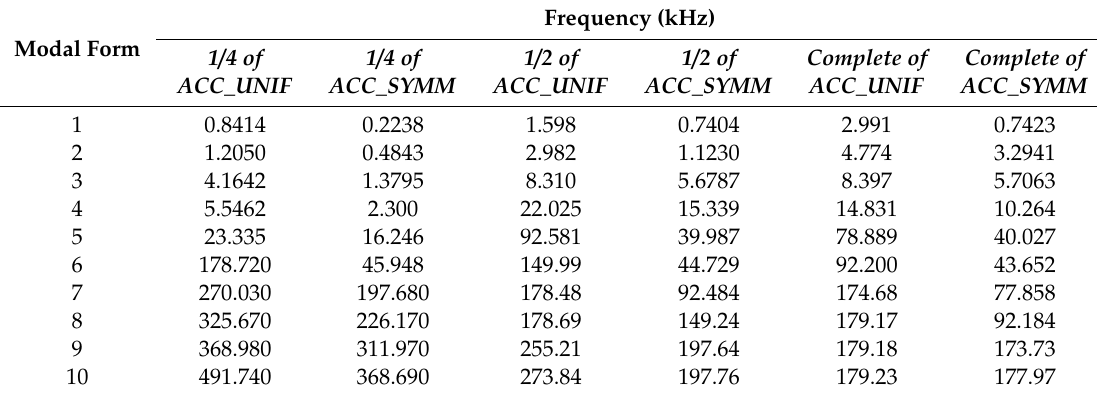
Table 9. Frequencies of the modal forms for all devices.